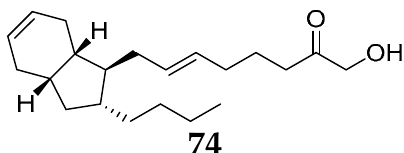
Figure 8. Other polyketide 74 from the subgenus Reniera.